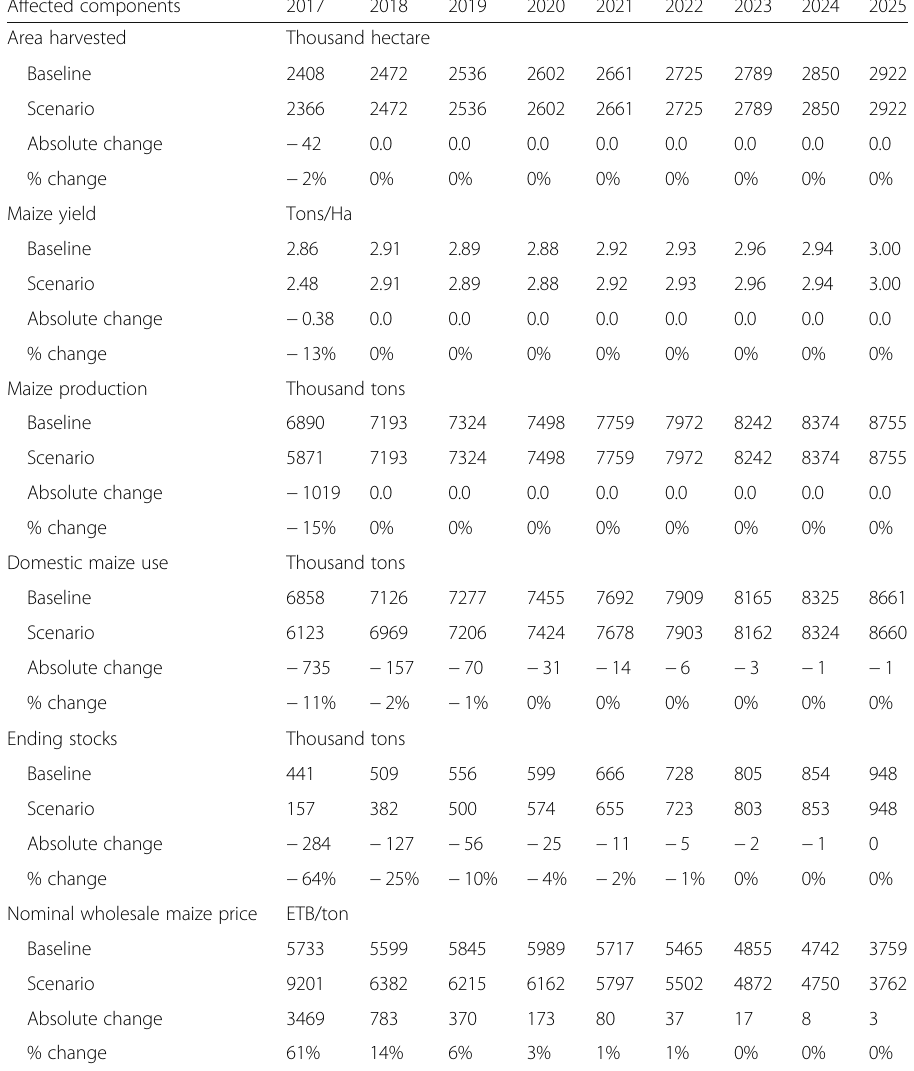
Table 8 Impact of a